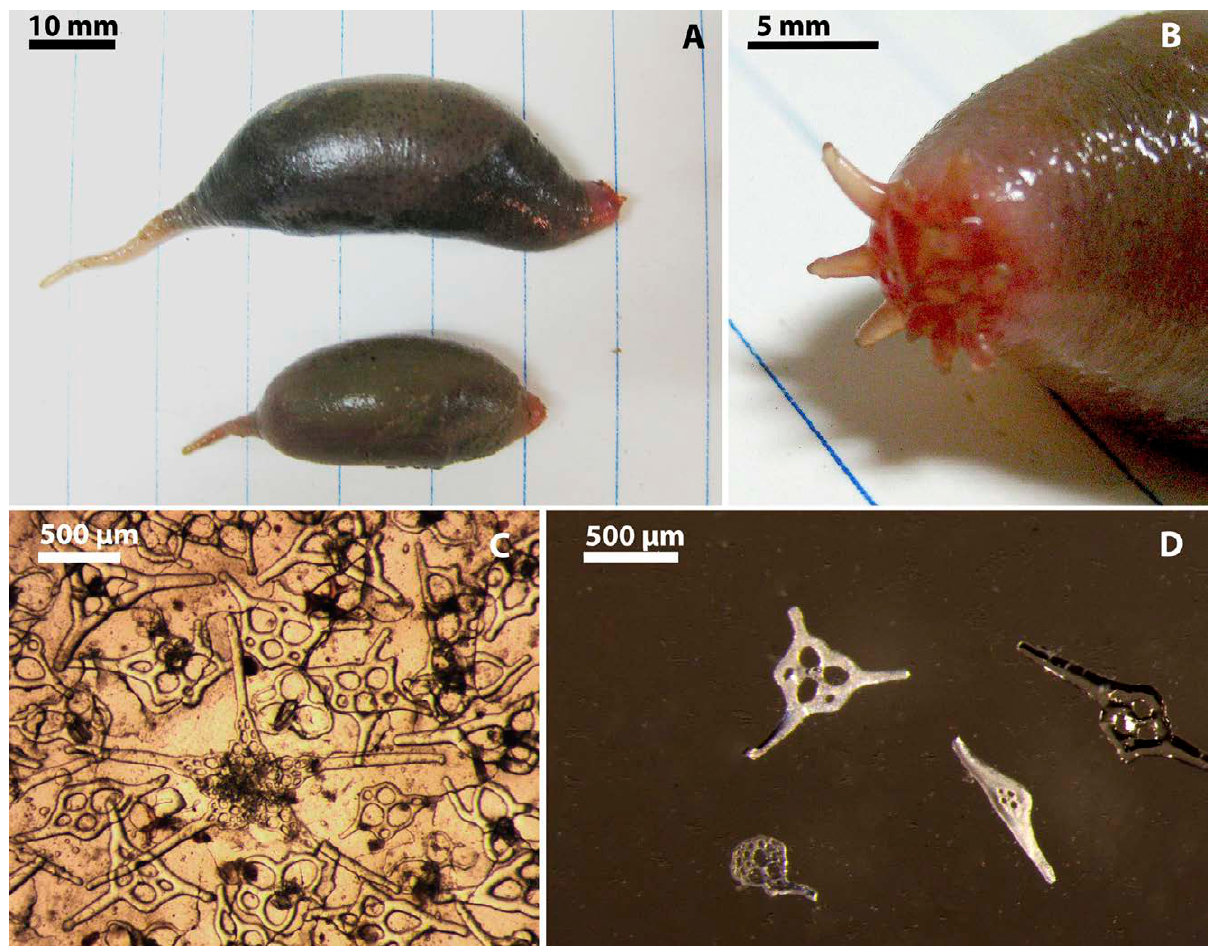
Fig. 10. – Molpadia musculus characteristics. A, general view; B, detail of the tentacles; C, rosettes and racquet-shaped ossicles with phos- phatic deposits; D, fusiform rod ossicles from